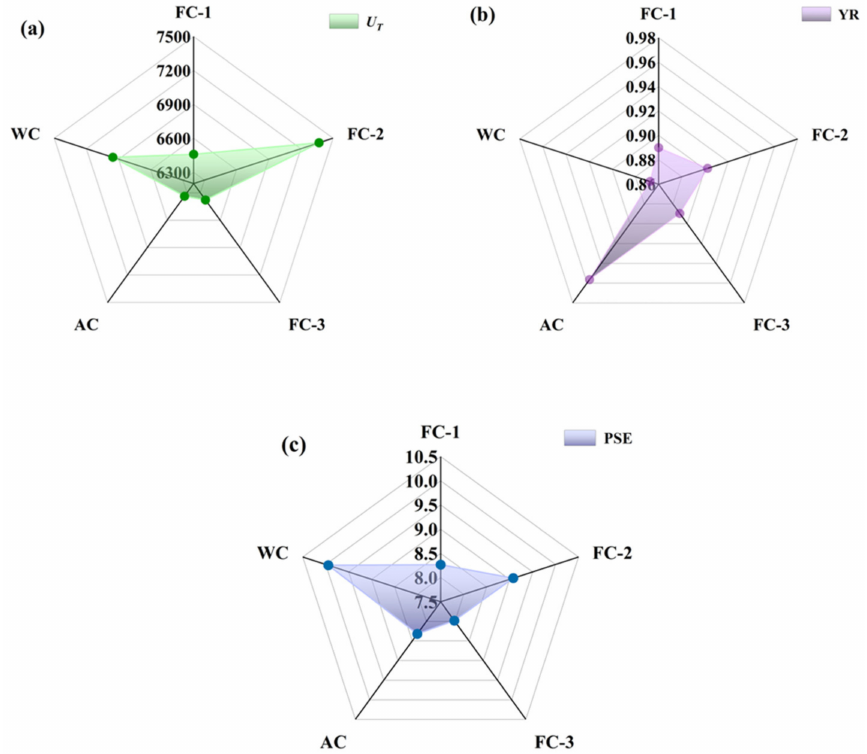
Figure 12. The variation of U T ( a ), YR ( b ), PSE ( c ) of Zr-4Hf-3Nb (wt%) alloy. with various cooling